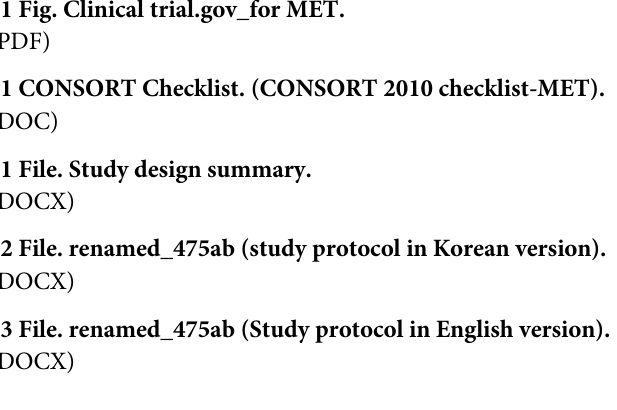
S1 Fig. Clinical trial.gov_for